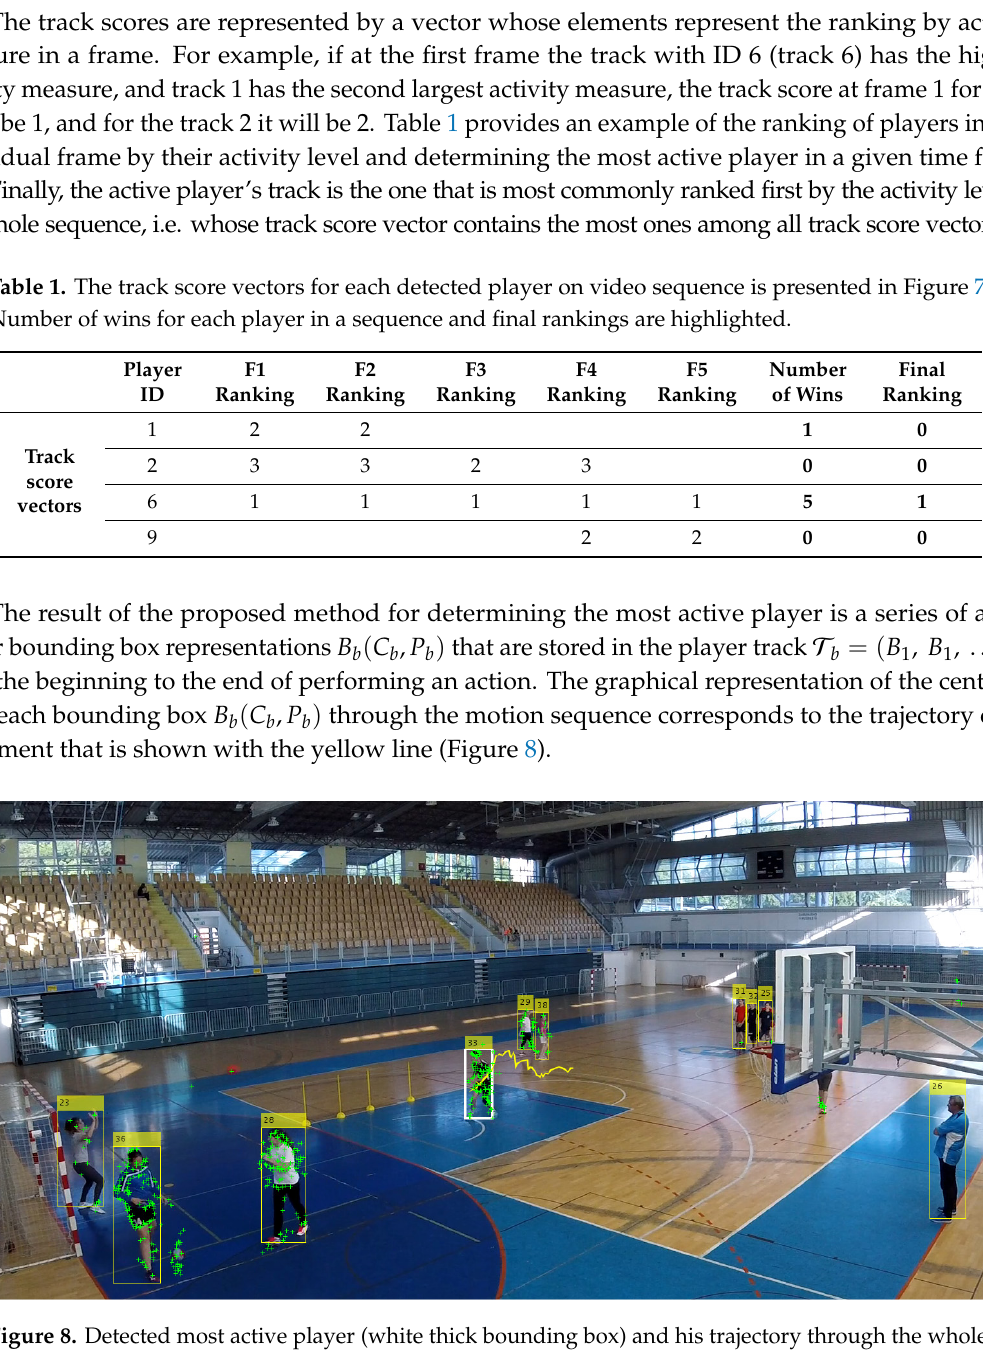
Figure 9. Extracted collage of the most active player's action. 4. Performance Evaluation of Active Player Detection and Discussion The proposed method was tested on a custom dataset that consists of scenes that were recorded during a handball training session. The handball training was organized in a sports hall or sometimes in an outdoor terrain, with a variable number of players without uniform jerseys, with challenging artificial lighting and strong sunshine, with cluttered background and other adverse conditions. The dataset consists of 751 videos, each containing one of the handball actions, such as passing, shooting, jump-shot, or dribbling. Multiple players, on average, 12 of them, appear in each video, as shown in Figure 10. Table 2 provides the statistics of the number of players per frame.